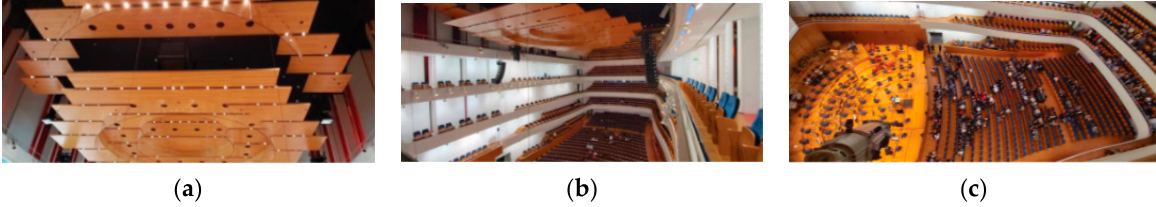
Figure 13. Salle Blanche in Kultur- und Kongresszentrum Luzern: ( a ) ceiling acoustic panel; ( b ) interior and the view of the circles and ( c ) interior and the view of the stalls; photograph by B. Majerska-Pa ł ubicka.